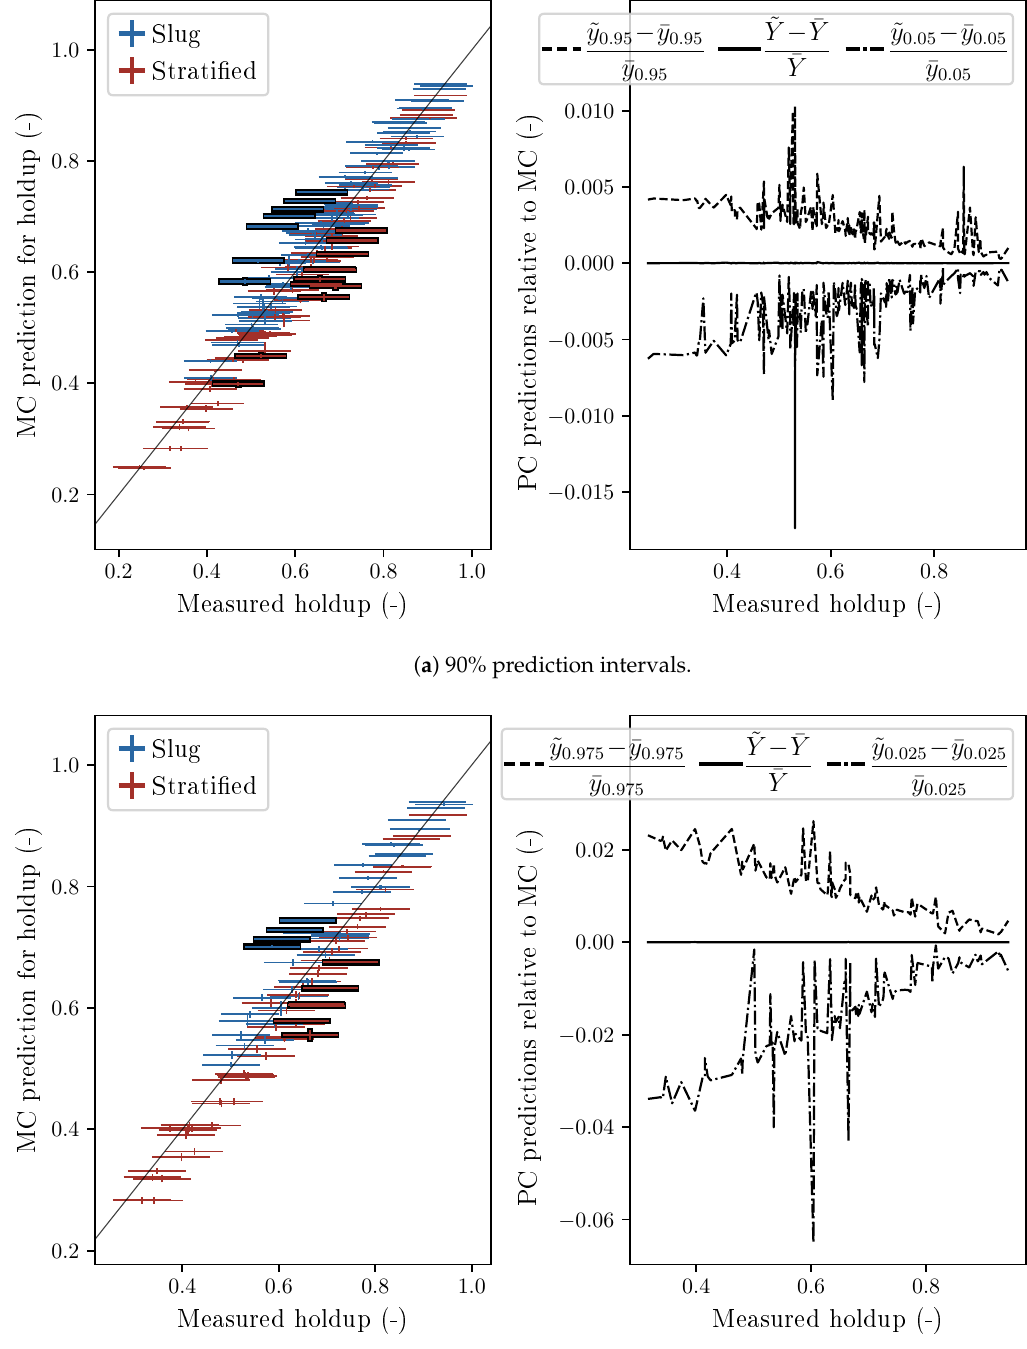
Figure 6. ( Left ) Predicted versus measured holdup for 194 experiments. The diagonal line is where the coordinates are equal, and cases with a discrepancy between prediction and observation are highlighted. The first axis gives measured value with two standard errors either way. The second axis is predicted mean, lower quantile and upper quantile. Slug experiments are blue and stratified ones are red. ( Right ) The relative difference in PC predictions compared to MC predictions with respect to measured holdup. Upper quantiles (dashed), means (solid) and lower quantiles